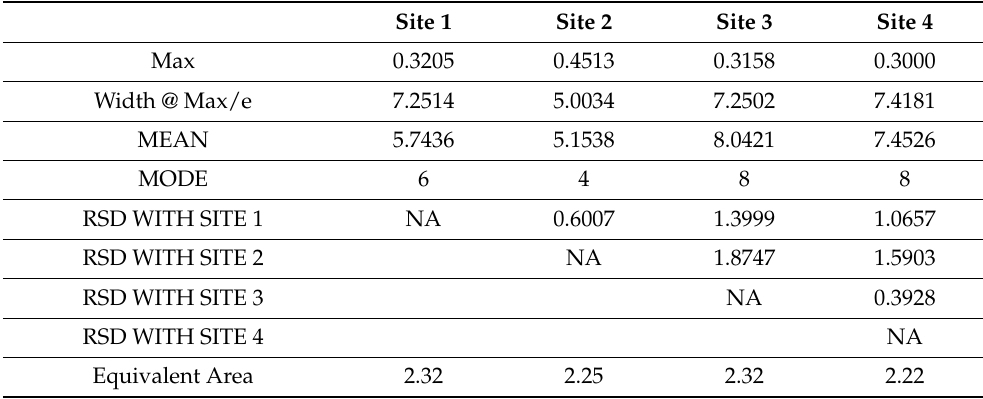
Table 7. Quality of the number of crossings at 1/16 max power as a